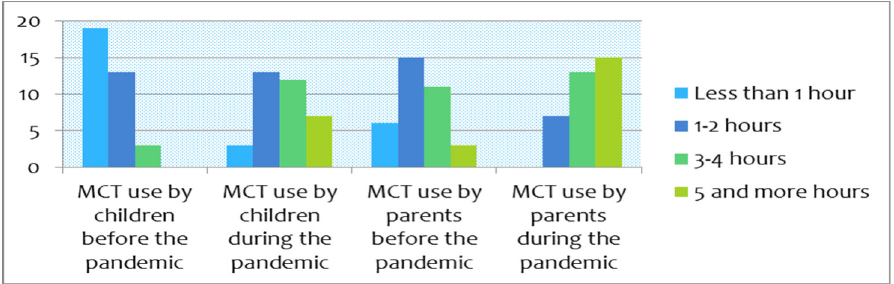
Figure 1: Daily MCT use by parents and